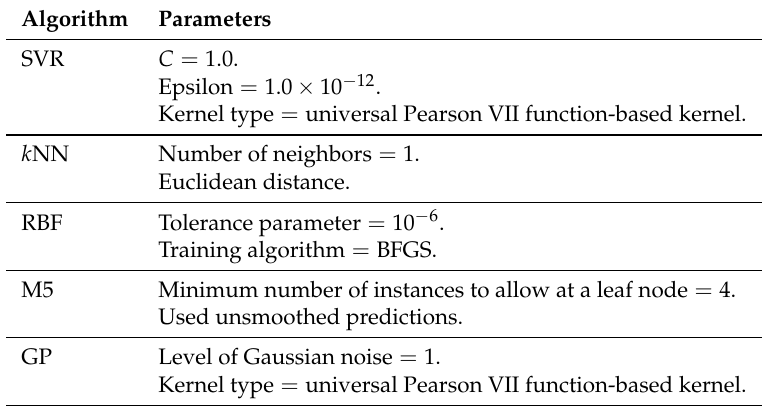
Table 1. Parameter specification for state-of-the-art regression algorithms used in the experimentation. Algorithm